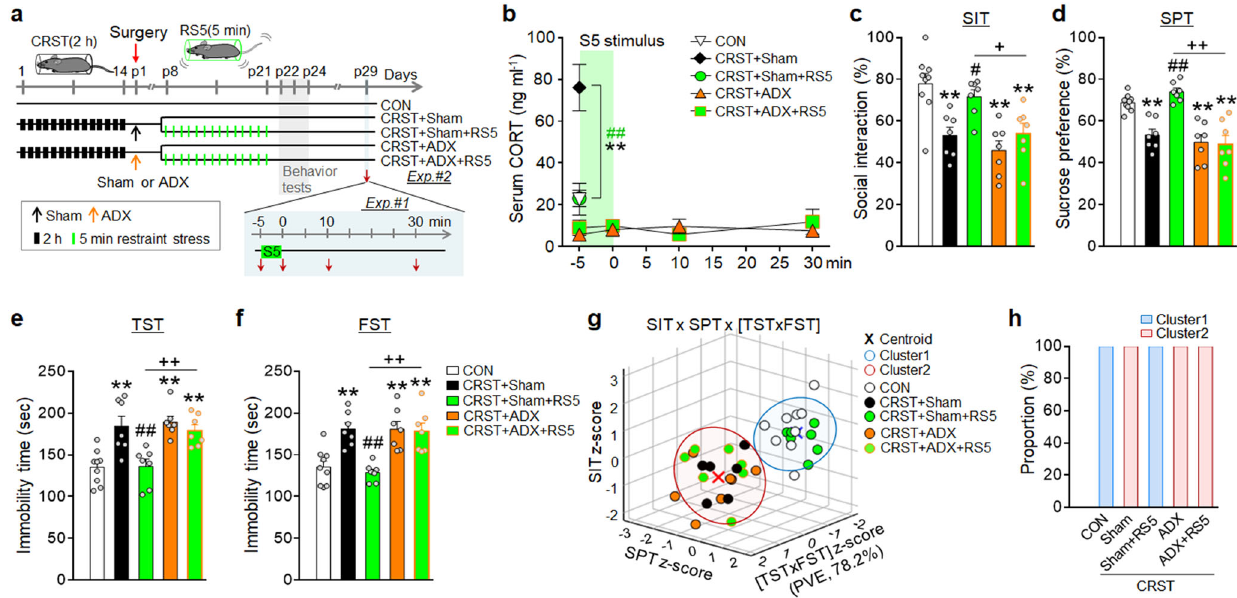
Fig. 3 Adrenalectomy (ADX) dissipates the anti-depressive effects of RS5 in CRST mice. a Experimental design. Mice were exposed to CRST, followed by ADX or sham surgery, and RS5 treatment, and then were placed in the behavioral tests. Red arrows ( ↓ ) in Exp #1, Serum collection points. Mice were sacri fi ced after exposure to a single 5-min restraint (S5). b – h The basal CORT levels at − 5 min, and the time course of serum CORT levels in the indicated groups after exposure to S5 (Exp #1) ( b ) ( n = 7 – 10 animals per group). The % time of social interaction in the SIT ( c ), the % sucrose-preference in the SPT ( d ), and immobility time in the TST ( e ) and FST ( f ) for the indicated groups (Exp #2). K -means clustering of individuals in the SIT × SPT × [TST × FST] matrix ( g ) and % composition of each group in the clusters ( h ). The TST and FST components were transformed into linear eigenvectors using PCA (PVE; 78.2%) ( n = 7 – 10 animals per group). Data were mean ± SEM. Gray circles represent individual data points. *, the difference compared to control; #, the difference compared to CRST; + , the difference compared to CRST + RS5. *, #, + , p < 0.05; **, ##, ++ , p < 0.01 (One-way ANOVA followed by Newman – Keuls post hoc test). See Supplementary Data 4 for statistical